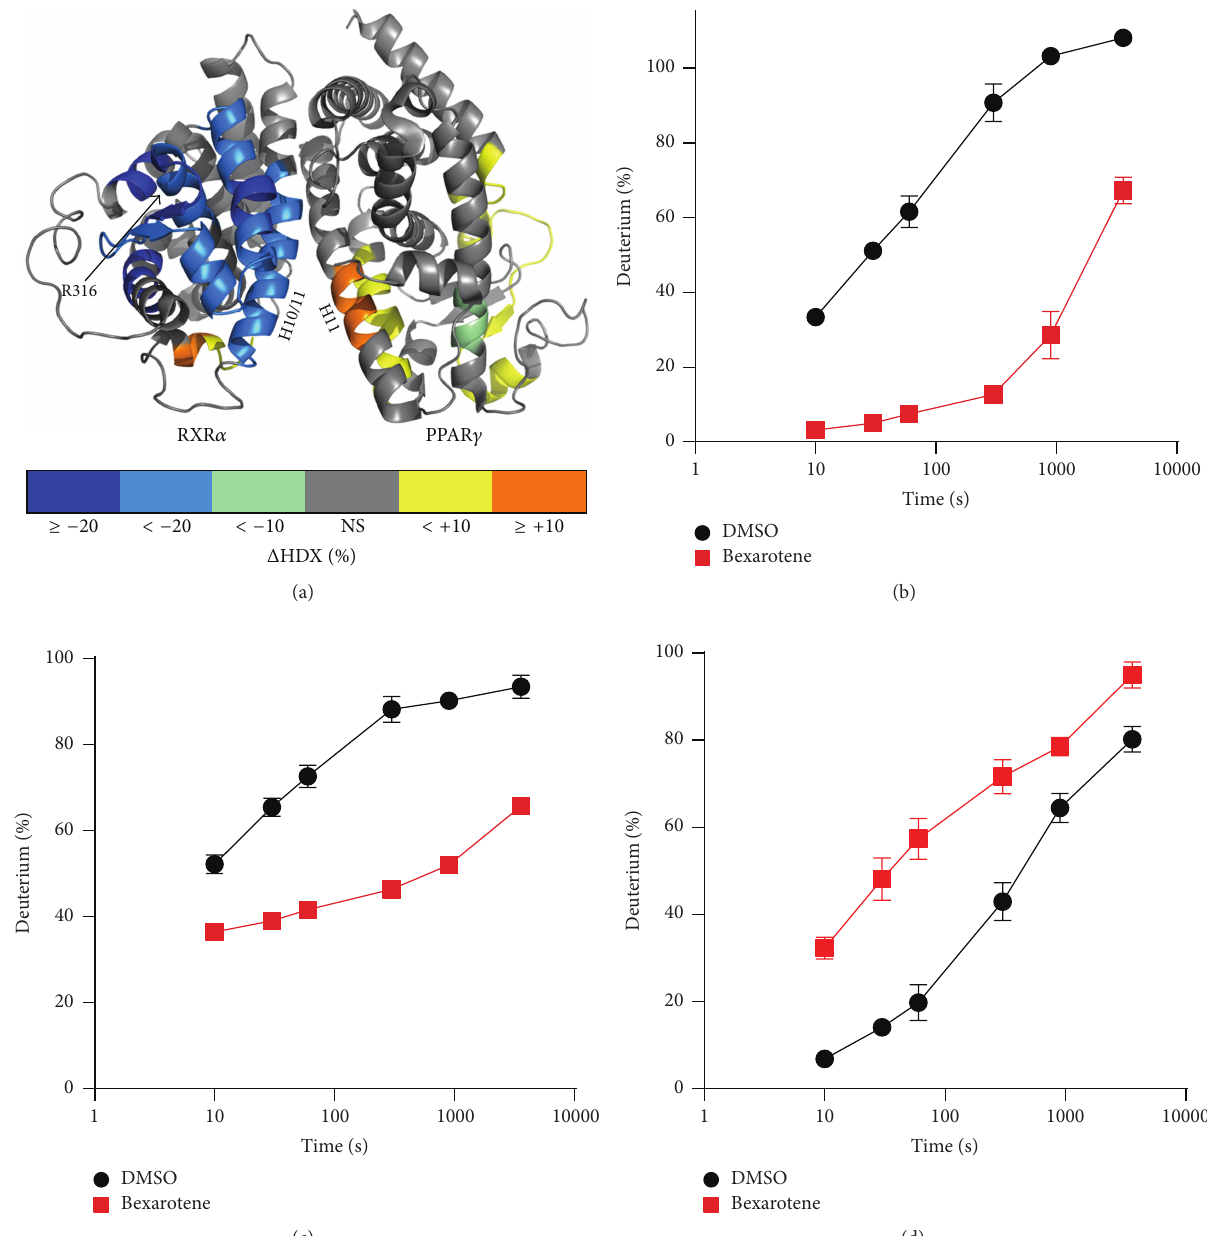
Figure 1: Differential HDX of PPAR 𝛾 :RXR 𝛼 heterodimer with Bexarotene: (a) residues colored corresponding to the average percent change in deuteration between apo and Bexarotene bound complex over 6 time points (10, 30, 60, 300, 900, and 3600 seconds) run in triplicate ( 𝑛 = 3 ) overlaid on PDB:1K74. HDX buildup curves of (b) RXR 𝛼 helix 10/11 peptide (RSIGLKC) at the dimer interface, (c) RXR 𝛼 peptide (SHRSIAVKDGIL) containing arginine 316 known to form a hydrogen bond with Bexarotene in crystal structure PDB 4K61, and (d) PPAR 𝛾 LBD helix 11 peptide (RQIVTEHVQL) at dimer